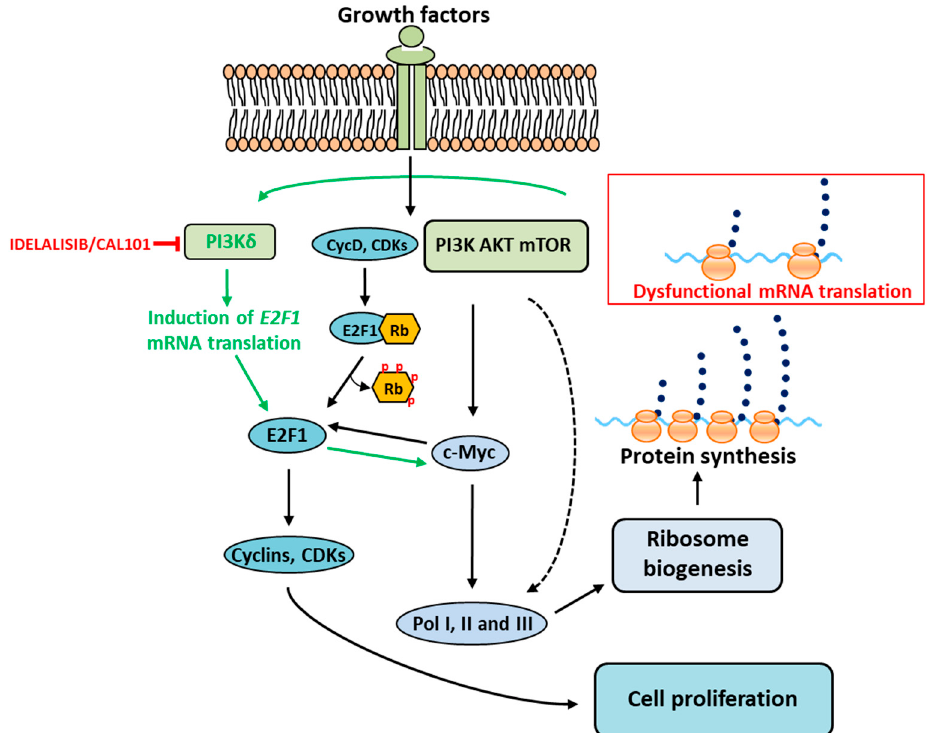
Figure 2. mRNA translation stress feedback to ribosome biogenesis and cell proliferation. Ribosome biogenesis and mRNA translation are large metabolic processes promoting the cellular growth and proliferation. Growth factors trigger the signaling cascades which induce RiBi via c-Myc and cell proliferation by activating the CDKs, E2F1, and cyclins (indicated with black arrows). In the case of dysfunctional mRNA translation (red box), stress signals from polysomes activate PI3K δ and trigger a novel signaling pathway (indicated with green arrows) independent of AKT and mTOR, resulting in increased translation of E2F1 mRNA. The newly synthesized active E2F1, in turn, stimulates the downstream transcription targets c-Myc and cyclins to induce ribosome biogenesis and cell proliferation. Idelalisib/CAL-101 is a selective inhibitor of PI3K δ (indicated with red T-bar). This novel signaling pathway provides the essential cellular feedback response to mRNA translation stress and its synchronization with ribosome biogenesis and cell proliferation.